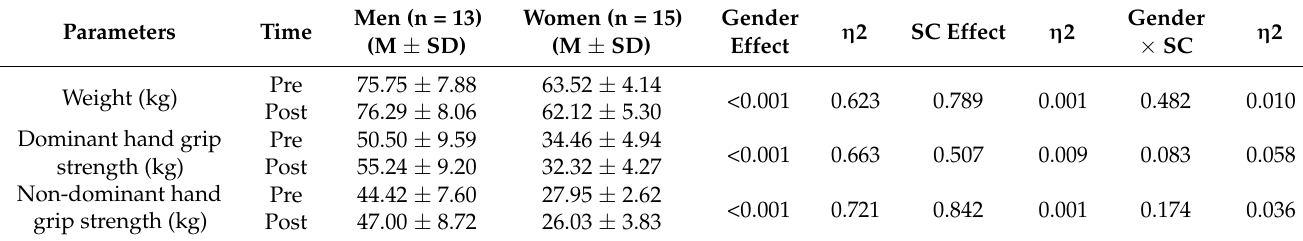
Table 3. The sample’s body weight and hand grip strength.